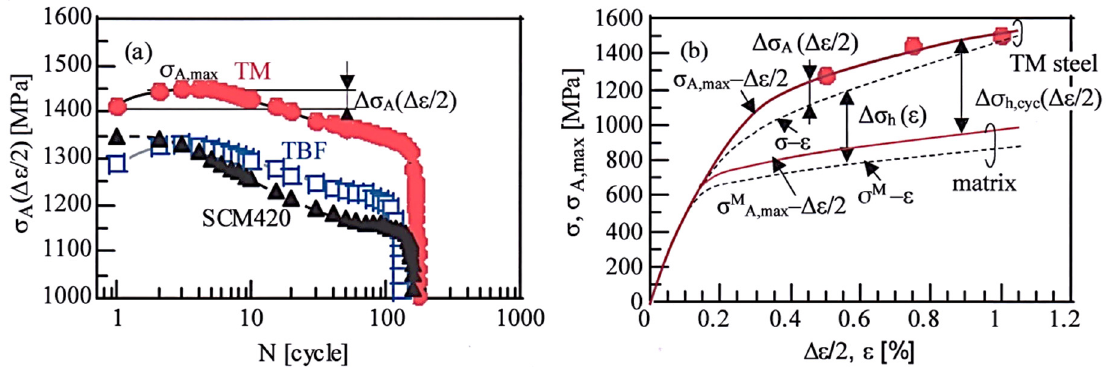
Figure 11. ( a ) Variations in stress amplitude ( σ A ( ∆ ε /2)) as a function of the number of cycles ( N ) under total strain amplitude of ∆ ε = 1.5% for 0.2%C–1.5%Si–1.5%Mn–1.0%Cr–0.2%Mo TM subjected to the IT process at T IT = 200 ◦ C and TBF steel ( T IT = 350 ◦ C), and JIS-SCM420 Q&T steel ( T T = 200 ◦ C). ( b ) Monotonic stress–strain ( σ - ε : dotted lines) and maximum cyclic stress amplitude–strain amplitude ( σ A,max - ∆ ε /2: solid red lines) curves for TM steel, as well as the definition of ∆ σ h ( ∆ ε /2), ∆ σ h,cyc ( ∆ ε /2), and ∆ σ A ( ∆ ε /2), in which σ M - ε and σ MA,max - ∆ ε /2 are the monotonic and cyclic curves of the assumed matrix structure in the TM steel, respectively [95]. Reprinted with permission from Springer Nature: Metall. Mater. Trans. A, Copyright 2021.